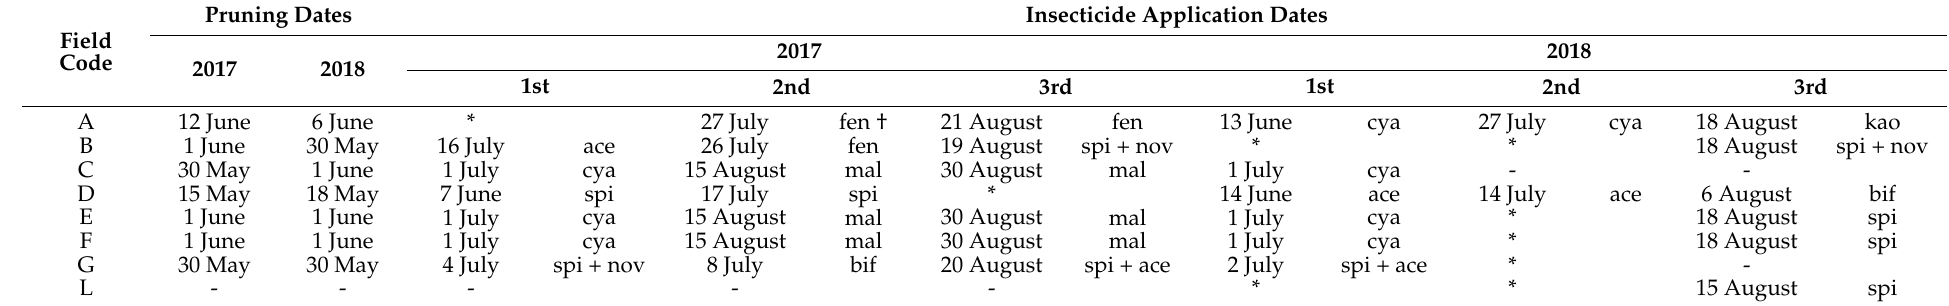
Table 2. Pruning and insecticide application dates for seven blueberry fields (code: A–G) in Hillsborough County, FL and one field (code: L) in Hernando County, FL, where young blueberry shoots were sampled to assess the distribution of S. dorsalis during summers of 2017 and